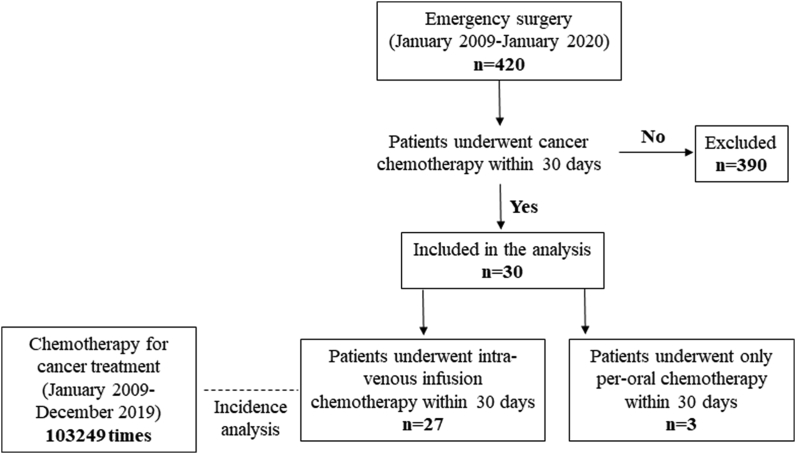
Overview of the patients included in the study.